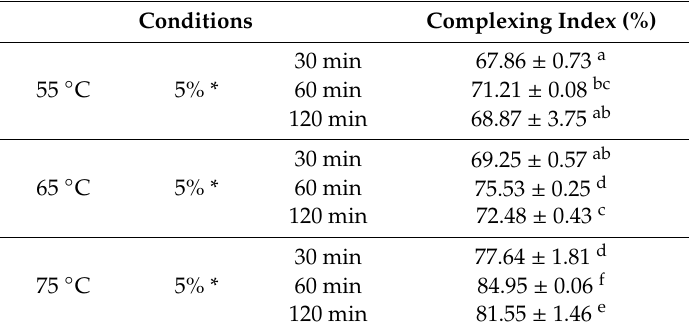
Table 1. E ff ect of time and temperature on amylose-lipid complex formation with stearic acid and corn starch.